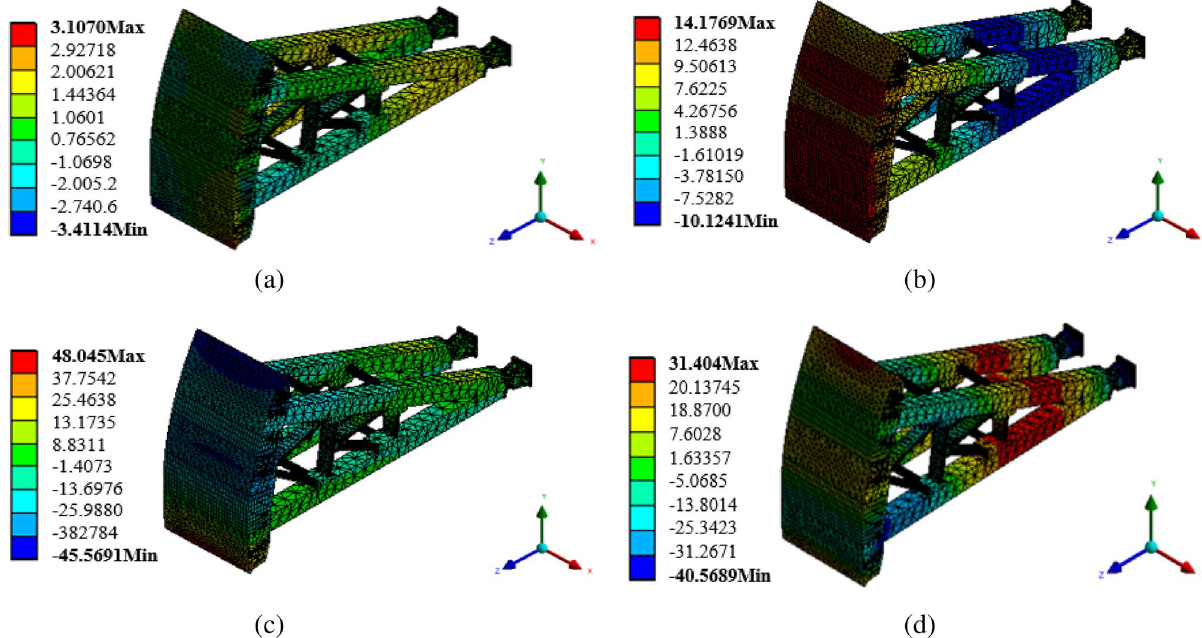
Figure 10. Nephogram of acceleration response of calculation model structure. ( a ) Nephogram of acceleration response in X direction, ( b ) Nephogram of acceleration response in Y direction, ( c ) Nephogram of acceleration response in Z direction, and ( d ) Nephogram of total acceleration response (unit: mm/s 2